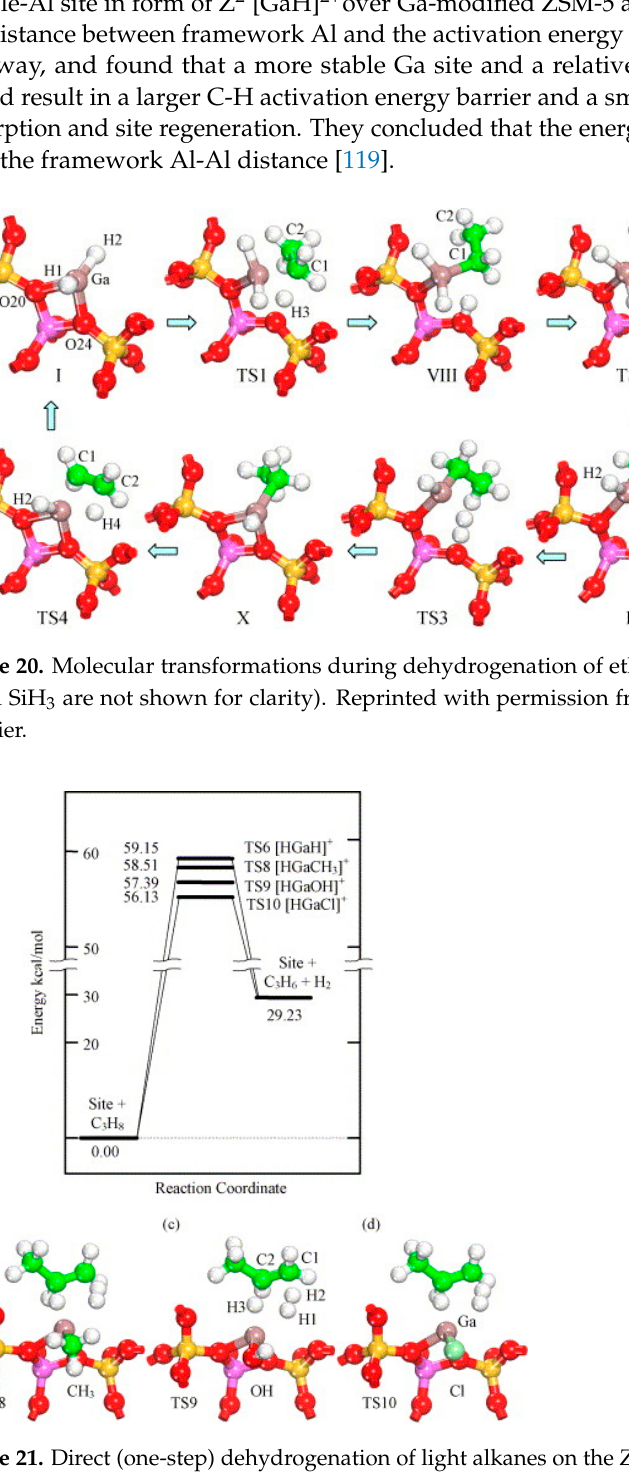
Figure 19. Dehydrogenation reaction of propane through the three-step mechanism (channel 1) computed with GaH 2 species and T22 cluster (B3LYP/6-31G**). Reprinted with permission from ref [133]. Copyright 2006 American Chemical Society.